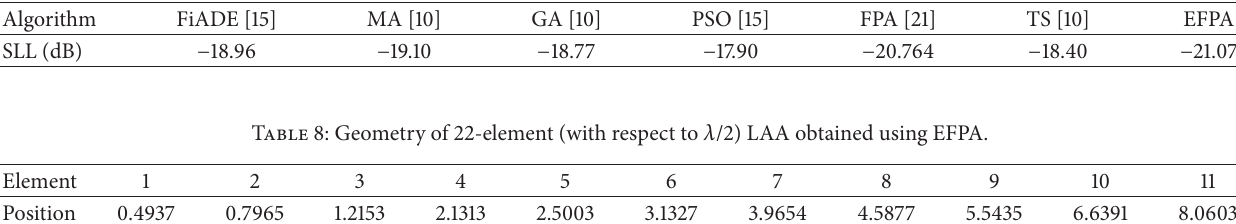
Table 7: Performance of different algorithms for 12-element LAA.